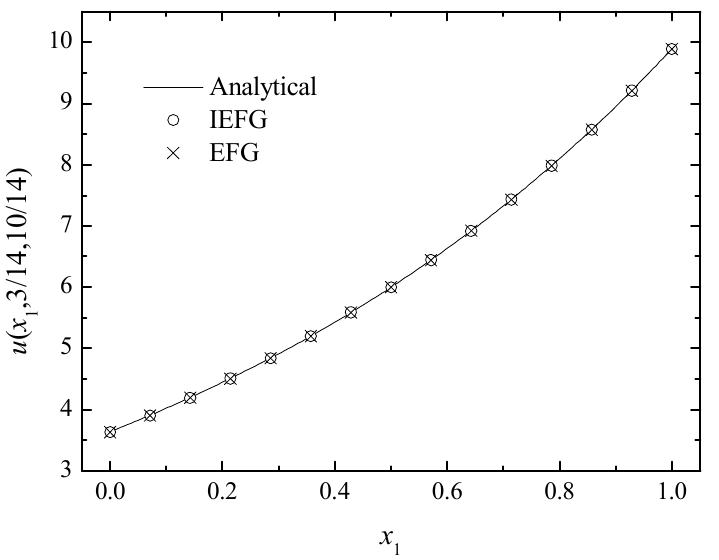
Figure 7. The comparison of the numerical and analytical solutions of the two methods along the x 1 -axis.